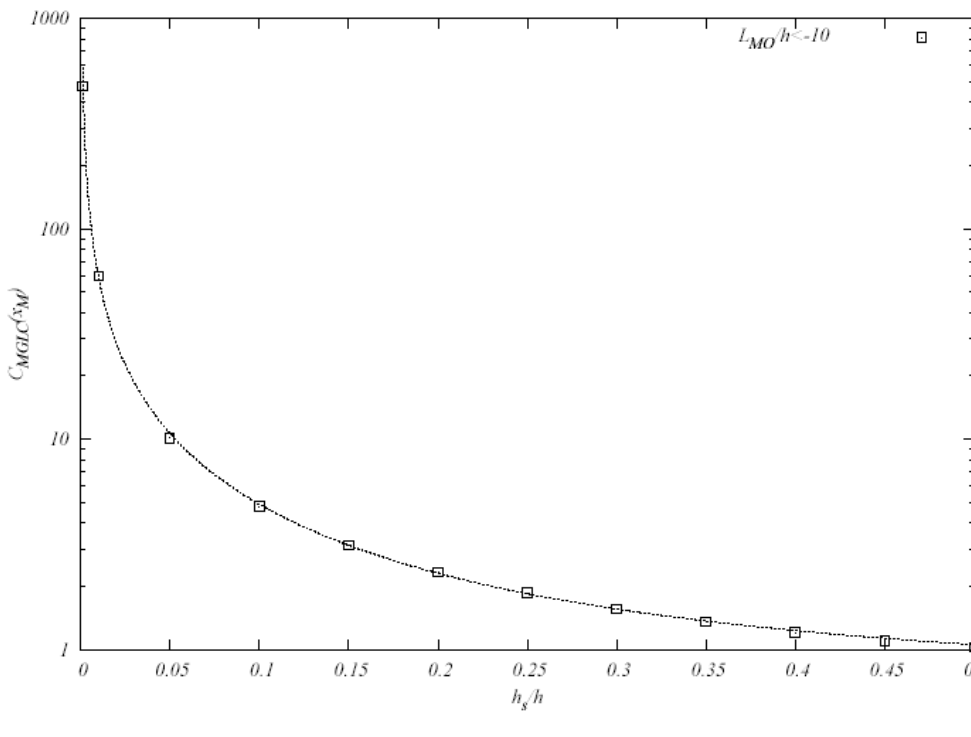
Figure 5. Value of the maximum GLC versus the source height hhh the GILTT results, dotted lines refer to Equation